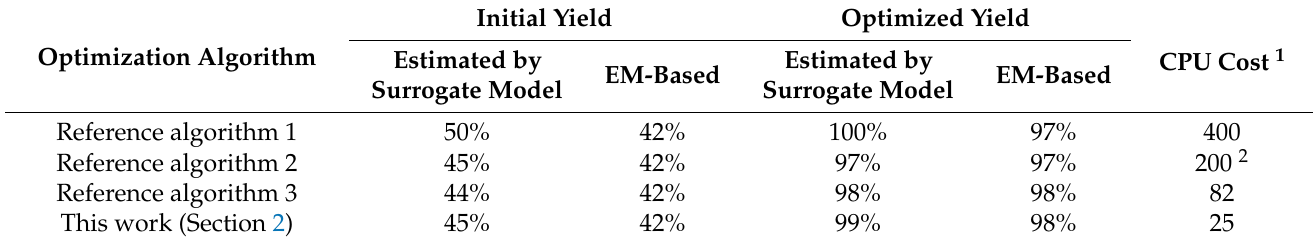
Table 2. Design centering results for Circuit I (Figure